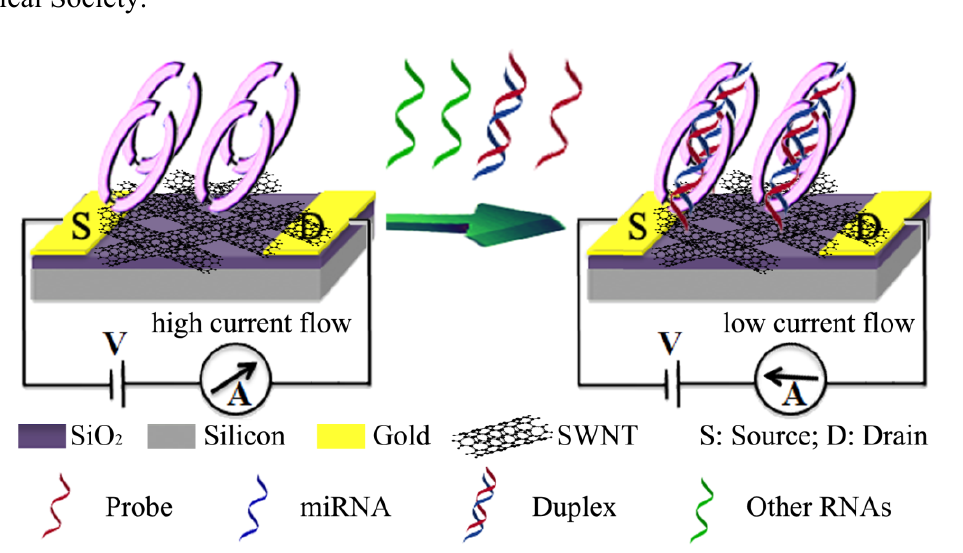
Figure 7. Schematic of miRNA detection principle by the p-19 functionalized CNTs-FET nanobiosensor. with